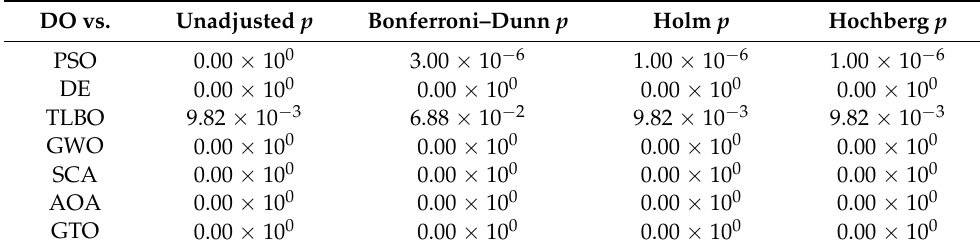
Table 11. Post hoc analyses for the multiple comparisons between DO and other nature-inspired algorithms when optimizing the delamination size at the bottom side. DO